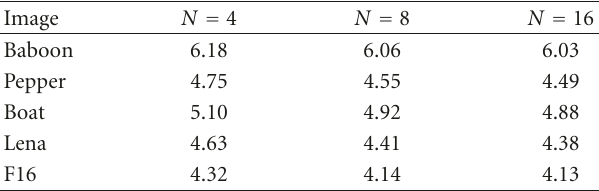
Table 2: Estimated (1 /n ) h ( x ) (in bits/dim or equivalently bits per pixel (bpp)) for di ff erent 512 × 512 8-bit grey images and block sizes n = N 2 , N = 4, 8 and